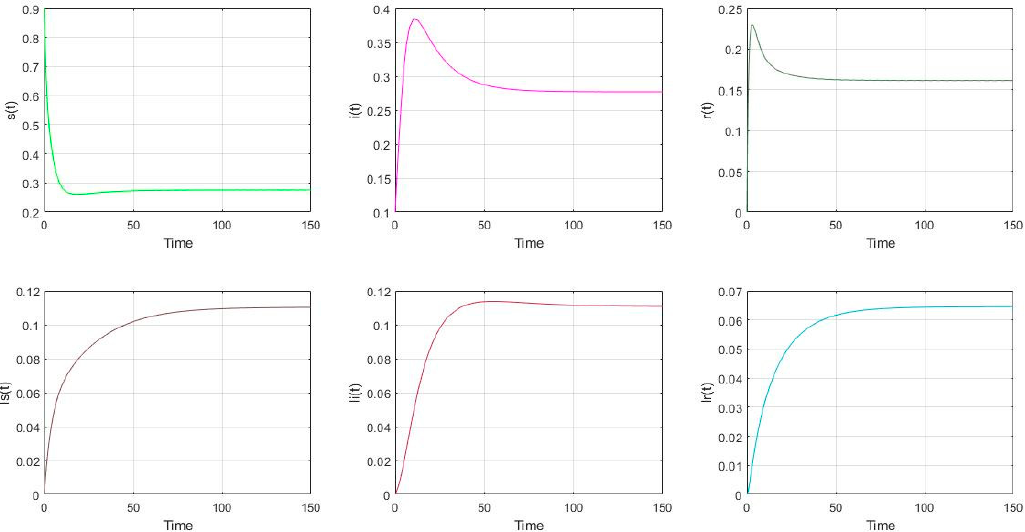
Figure 3. The distribution of nodes if R 0 = 1.8633 and β 2 = 0. (3) The parameter settings are as follows in Figure 4: 𝑏 = 0.05, 𝛼 (cid:2869) = 0.87, 𝛼 (cid:2870) = 0.02, 𝛼 (cid:2871) =